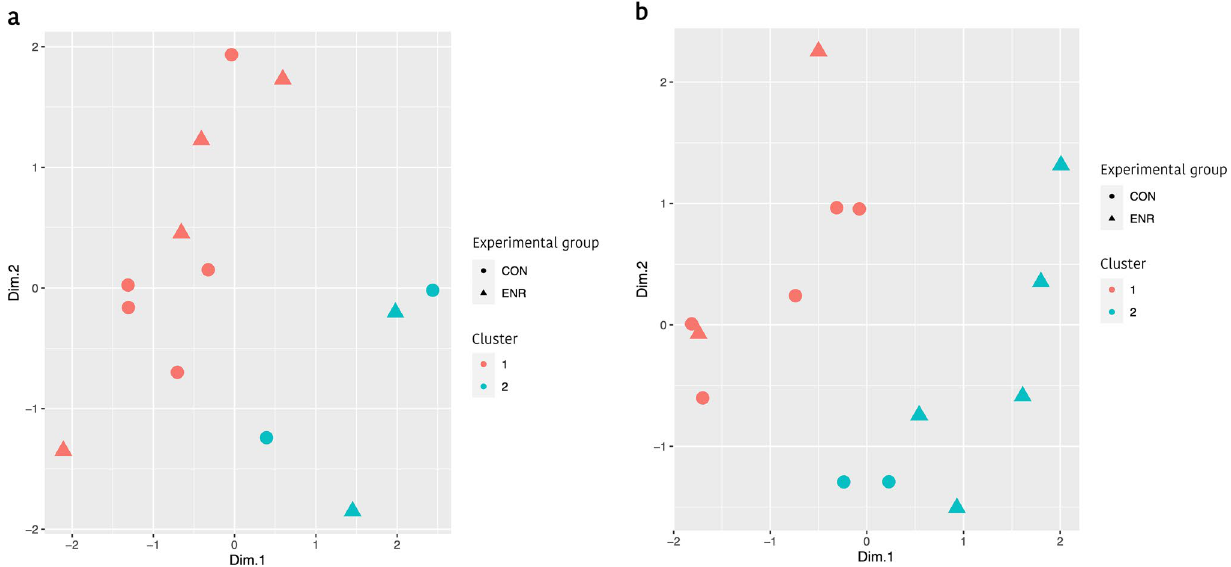
Figure 3. Scatterplot of cluster stratification according to LinkHD blind analysis. a The clustering of the samples during lactation, whereas b shows the clustering of the samples after weaning. A similar cluster distribution was observed with the hierarchical grouping dendrogram by using the UPGMA (average method) based on Bray–Curtis distances and relative OTU counts (Fig. 1). Figures created by using open-source software R v3.5.3. (https ://www.r-proje ct.org/found ation